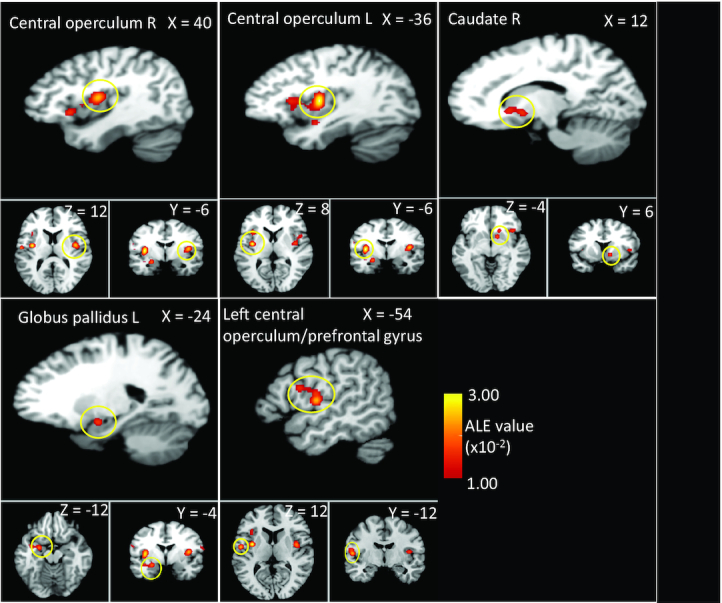
Localization of significant ALE clusters from the sucrose minus control and glucose minus control contrast studies combined meta-analysis of sweet taste in human adults. GingerALE output overlaid onto a standard template (Colin27_T1_seg_MNI.nii) in MNI space. ALE, activation likelihood estimation; MNI, Montreal Neurological Institute.